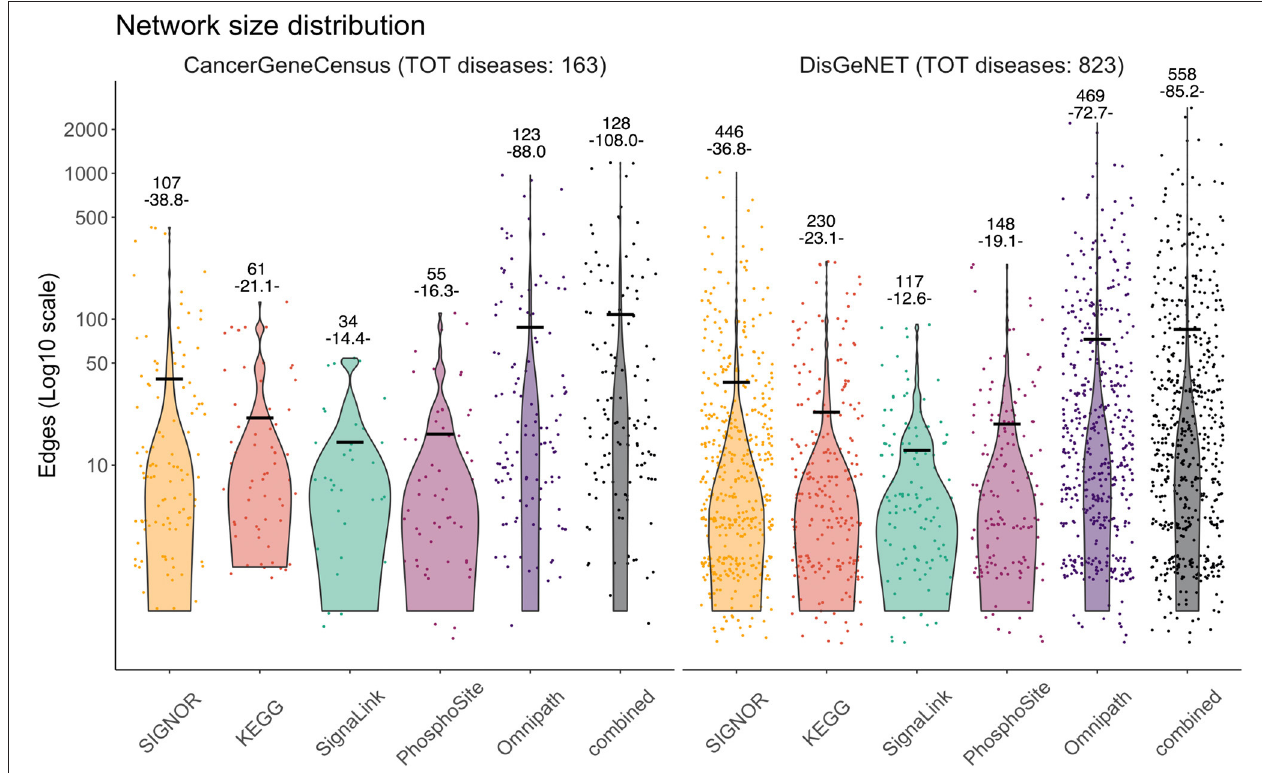
FIGURE 4 | Violin plots illustrating the size distribution of the disease-networks that can be assembled by linking disease genes via causal interactions annotated in AF Databases. Disease-networks were assembled by using gene-disease associations (GDAs) downloaded from the Cancer Gene Census (left panel) ( Sondka et al., 2018) and from DisGeNET selecting GDAs with score > 0.5 (right panel) (Piñero et al., 2020). The disease-networks also include proteins that directly connect disease gene products (bridge proteins) ( Lo Surdo et al., 2018). Only diseases with at least two GDAs were considered in this analysis. Each dot represents a disease network and its size (y-axis) is defined as the number of edges that can be extracted from the five AF resources: SIGNOR (in yellow), KEGG (in red), PhosphoSitePlus (in purple), SignaLink (in green) and OmniPath (dark purple); and from a network derived by taking into considerations all the relationships annotated in at least one resource, combined (black). On top of each violin the total number of disease-networks that can be assembled by using the annotated causal relationships from each corresponding resource is displayed. In brackets we show the average size of the network, also indicated by a horizontal black